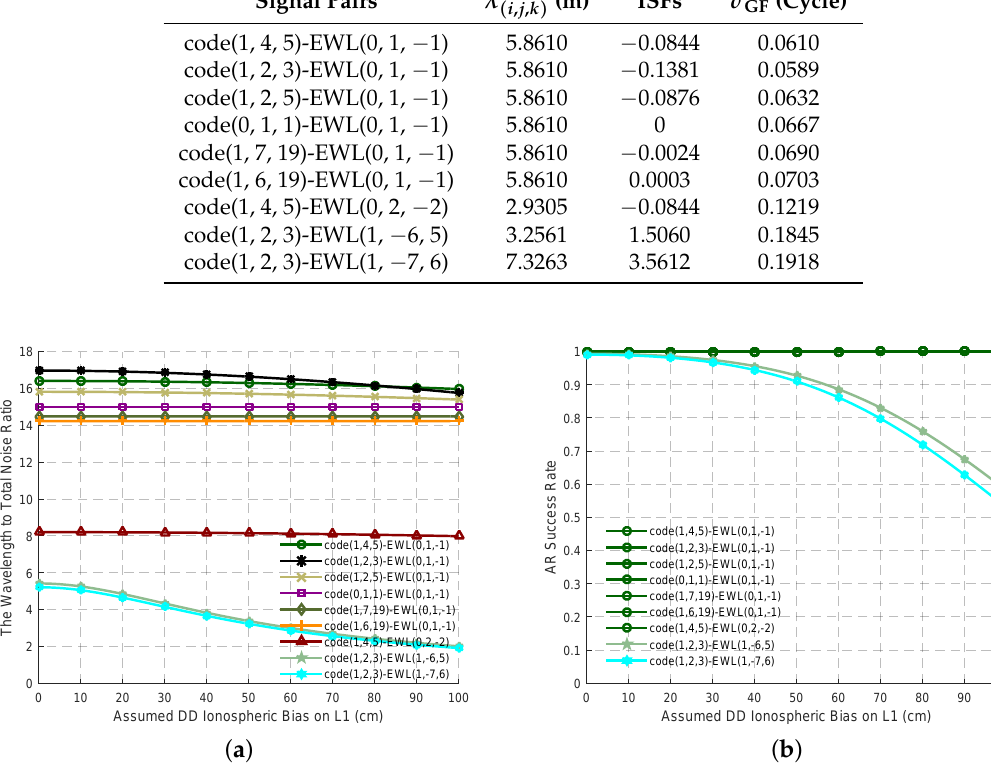
Figure 2. The variation trend of the wavelength to total noise ratio and the AR success rates of the signal pairs in Table 1 for GF TCAR. ( a ) The wavelength to total noise ratio; ( b ) AR success